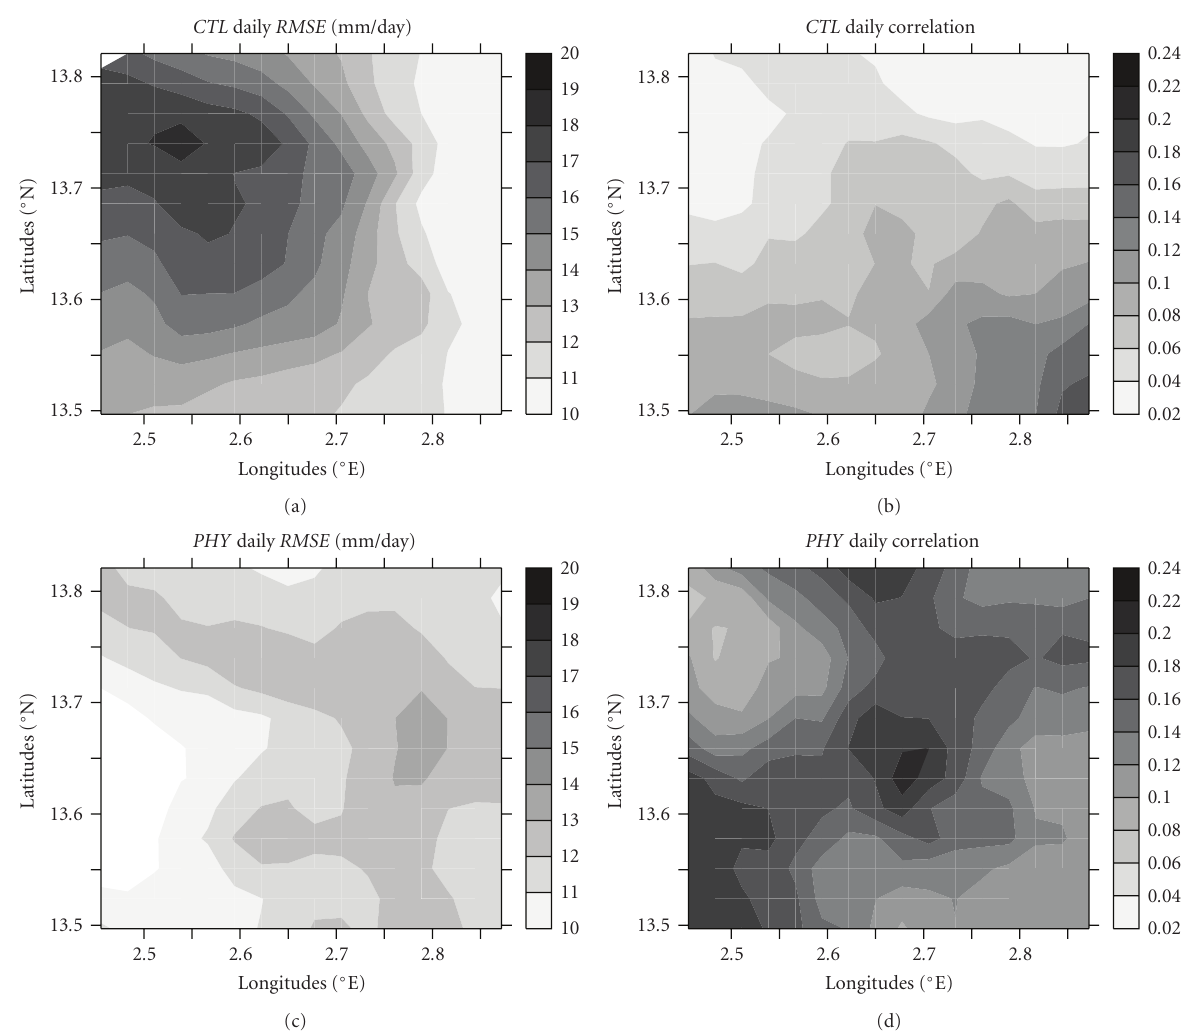
Figure 3: Statistical comparison ( RMSE and correlation) between simulated and observed daily precipitations over Dantiandou